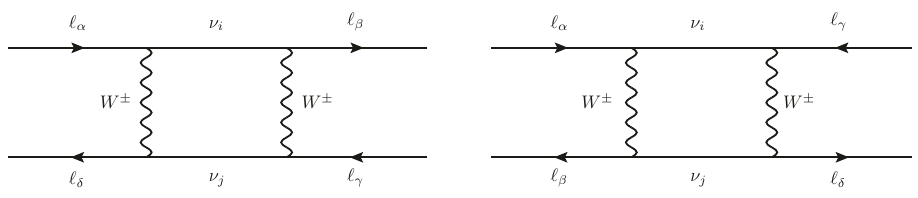
. Although we only display the W ± → ‘ − ‘ + ‘ − α γ β δ